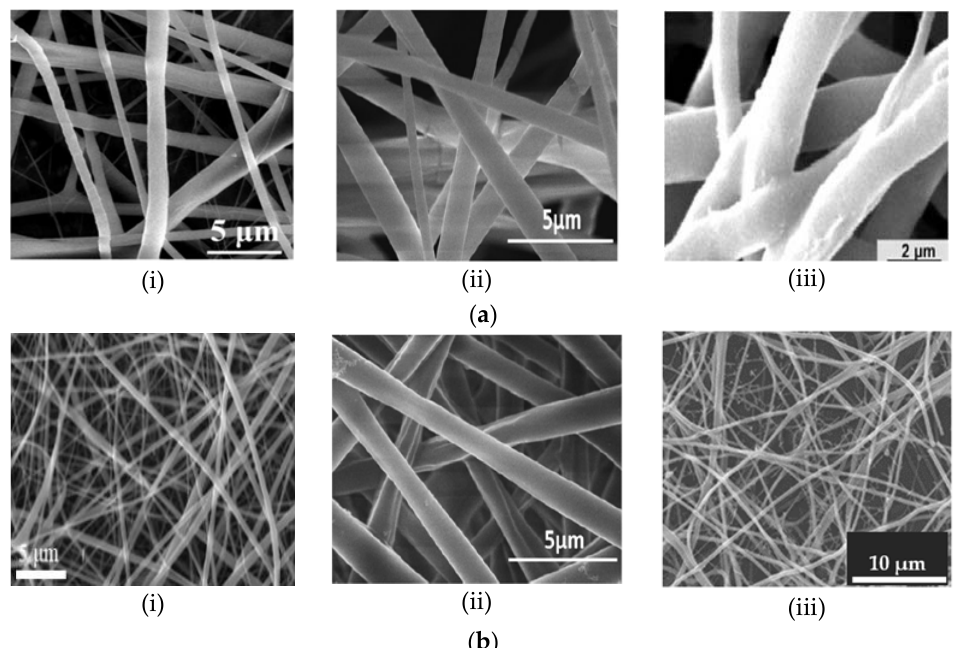
Figure 1. Scanning electron microscope (SEM) micrograph illustrations of nanofibers (NFs) com ‐ posed of ( a ) pure synthetic polymers (i) PCL [18] , (ii) PLLA (Reprint with permission from